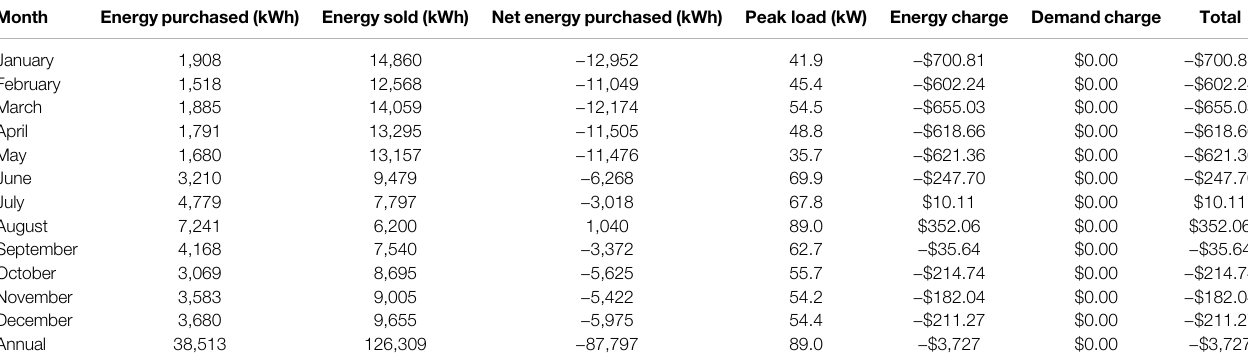
TABLE 7 | Energy purchased (kWh) and energy sold (kWh) rates to Grid of